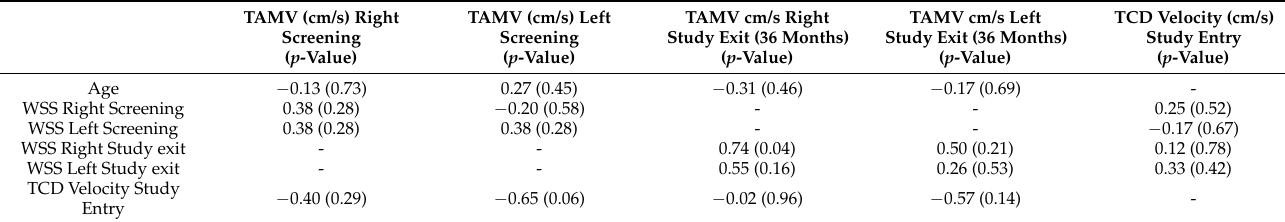
Table 2. Showing results of Spearman’s correlation analysis, to determine whether there is a cor- relation between participant’s age, TCD velocity at screening and TAMV or WSS at screening or study exit. We did not examine the other time points because of high rate of missingness for the TCD velocity data at the pre-randomization and study exit time points.